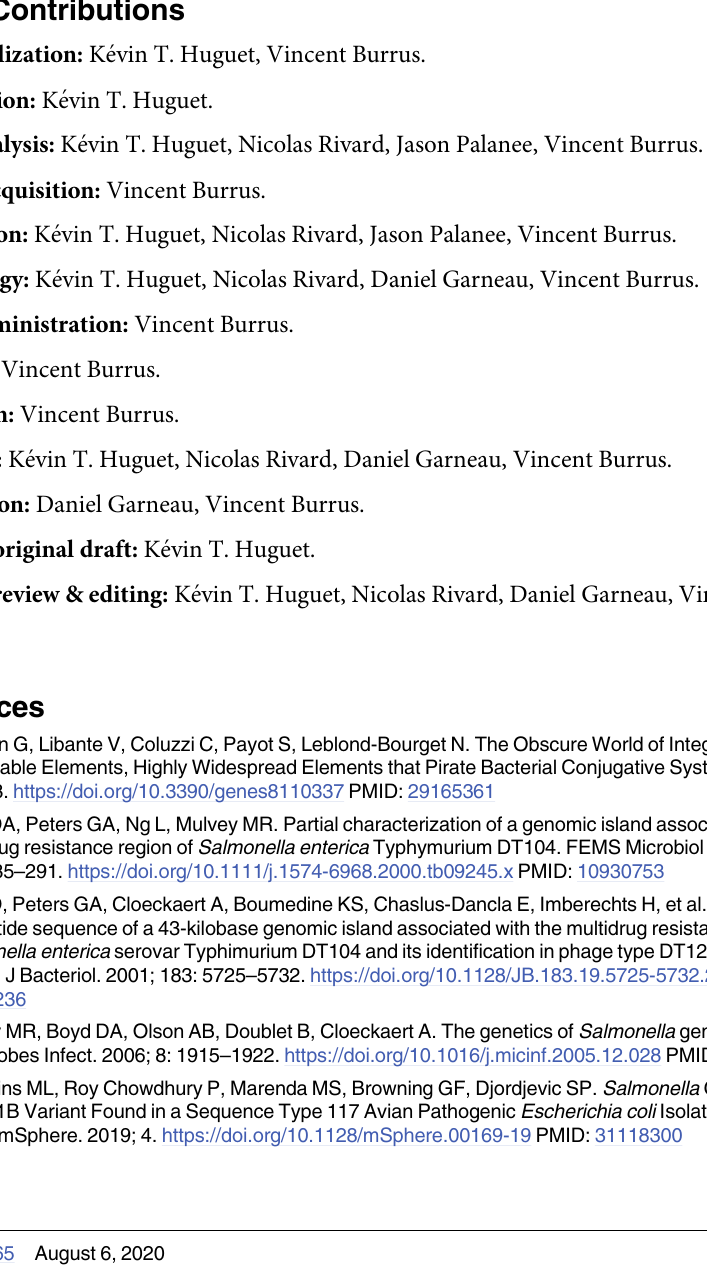
S7 Fig. Impact of oriV on SGI1 replication. Evolution of the percentage of E . coli KH95 cells bearing pVCR94 Green and SGI1 Red Δ oriV over 54 generations in the absence of antibiotics as monitored using